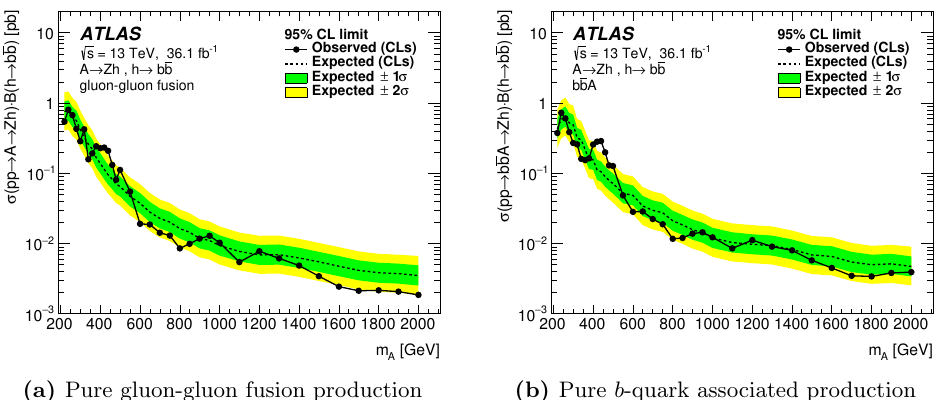
Figure 6. Upper limits at the 95% CL on the product of the production cross-section for pp ! A and the branching fractions for A ! Zh and h ! bb evaluated by combining the 0-lepton and 2-lepton channels. The possible signal components of the data are interpreted assuming (a) pure gluon-gluon fusion production, and (b) pure b -quark associated